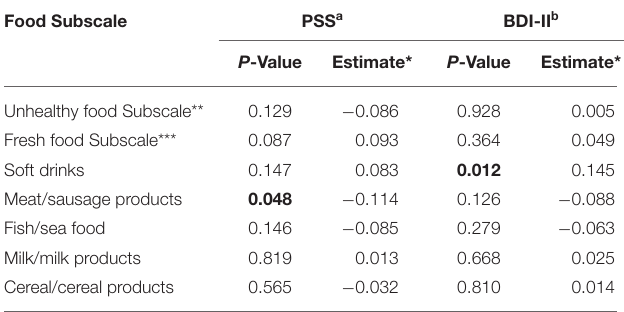
TABLE 3 | Food groups, PSS and BDI-II (multivariable analysis).